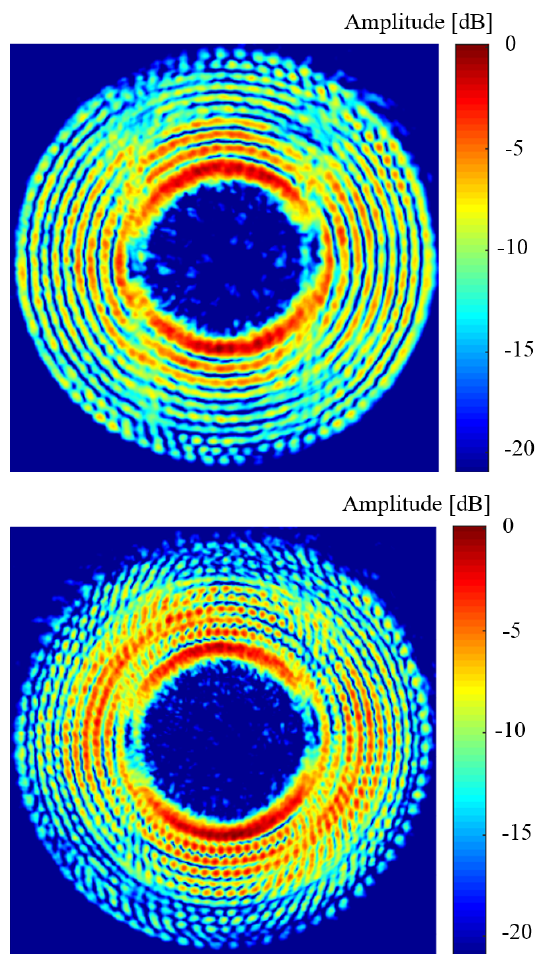
Fig. 7. Measured normalized pattern (electric field amplitude – vertical polarization) of the TE 28,10 mode at 140.155 GHz (top) and of the TE 36,12 mode at 175.992 GHz (bottom). The plots refer to a 70 mm × 70 mm domain.